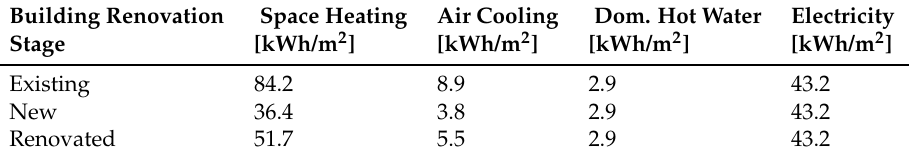
Table 3. Yearly specific energy service demand of administrative buildings.